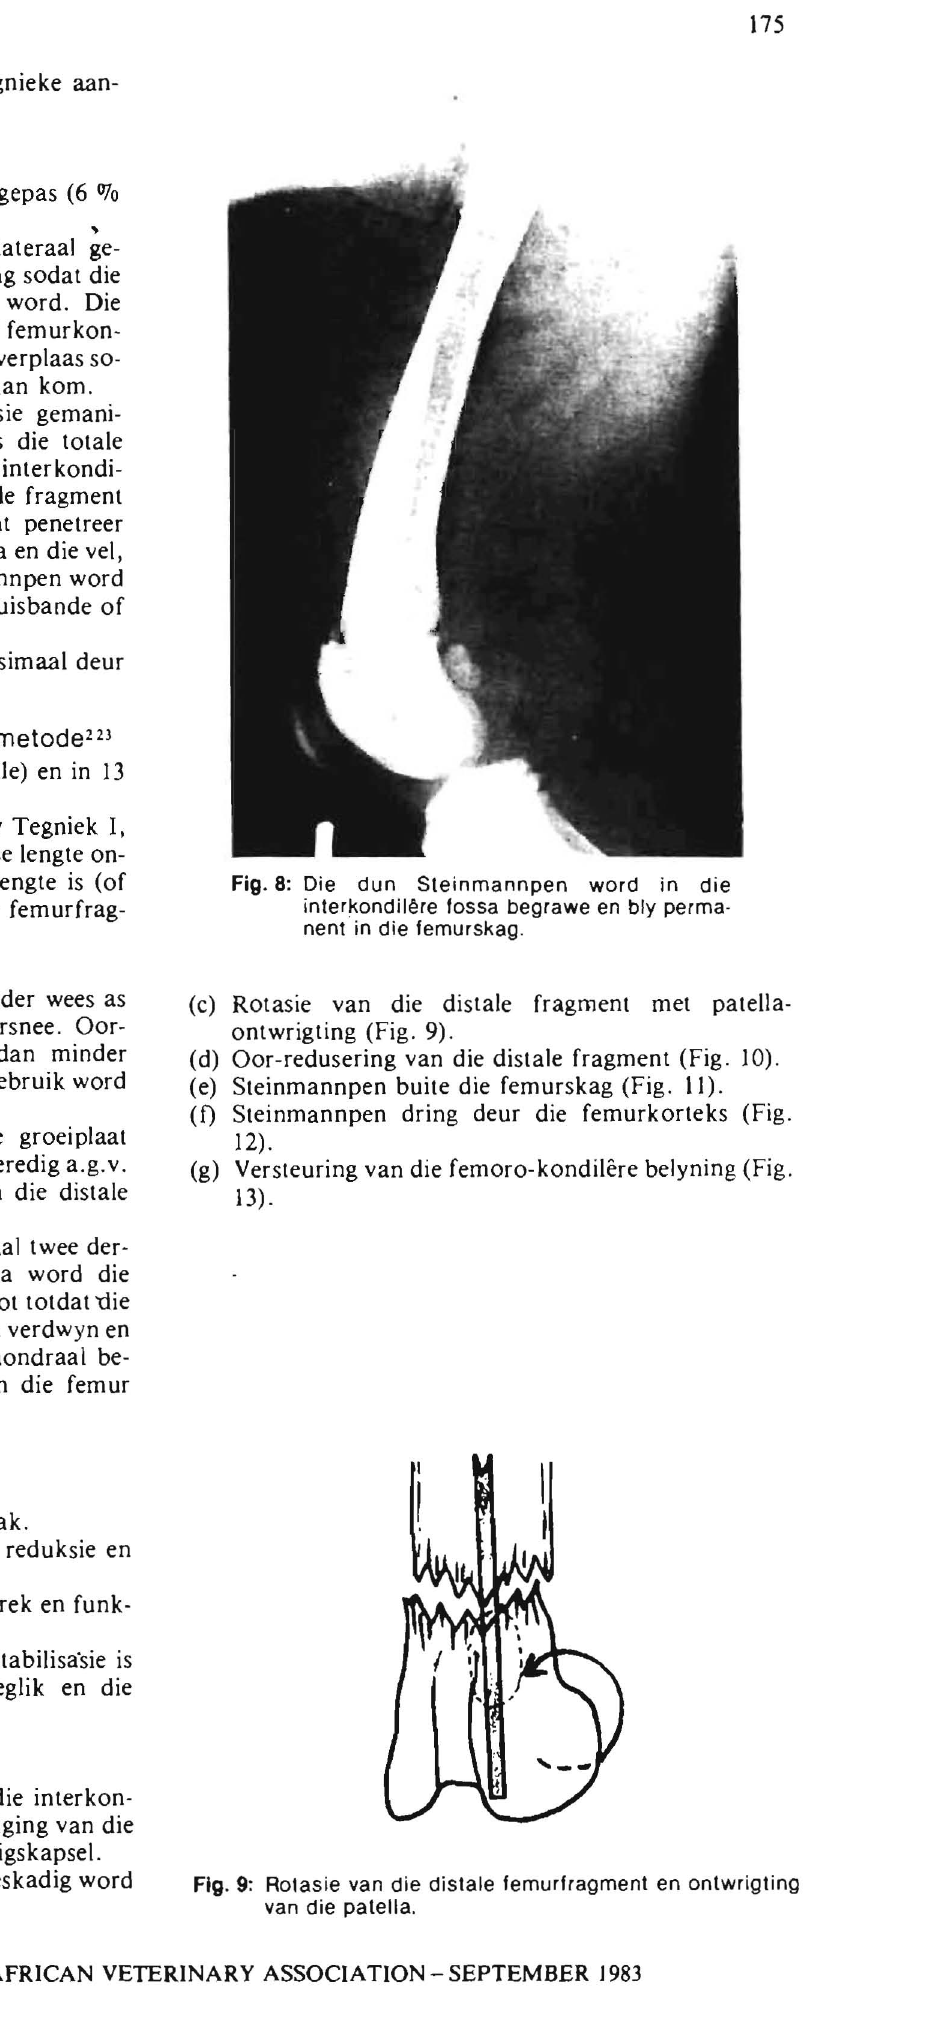
Fig. 9: Rotasie van die distale femurfragment en ontwrigting van die